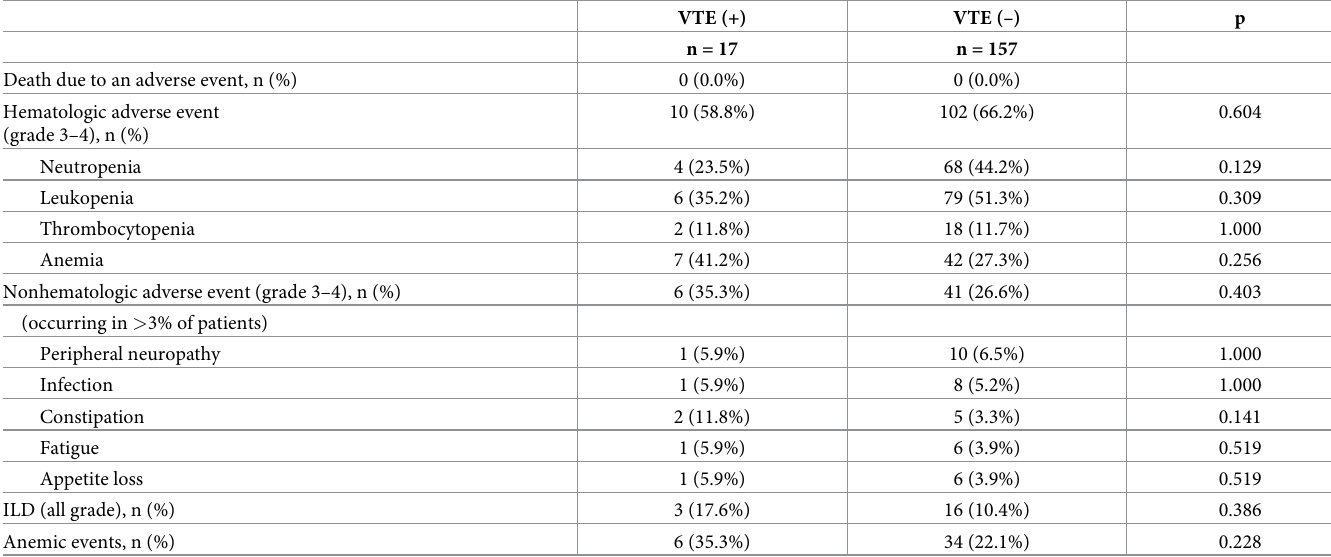
Table 3. Severe (grade 3–4) adverse events.